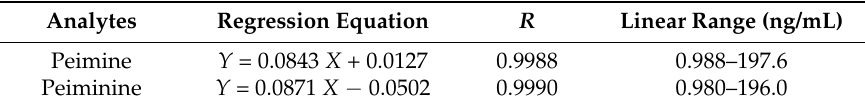
Table 2. The regression equations, correlation coefficients and linear ranges for the determination of the analytes in beagle dog plasma.